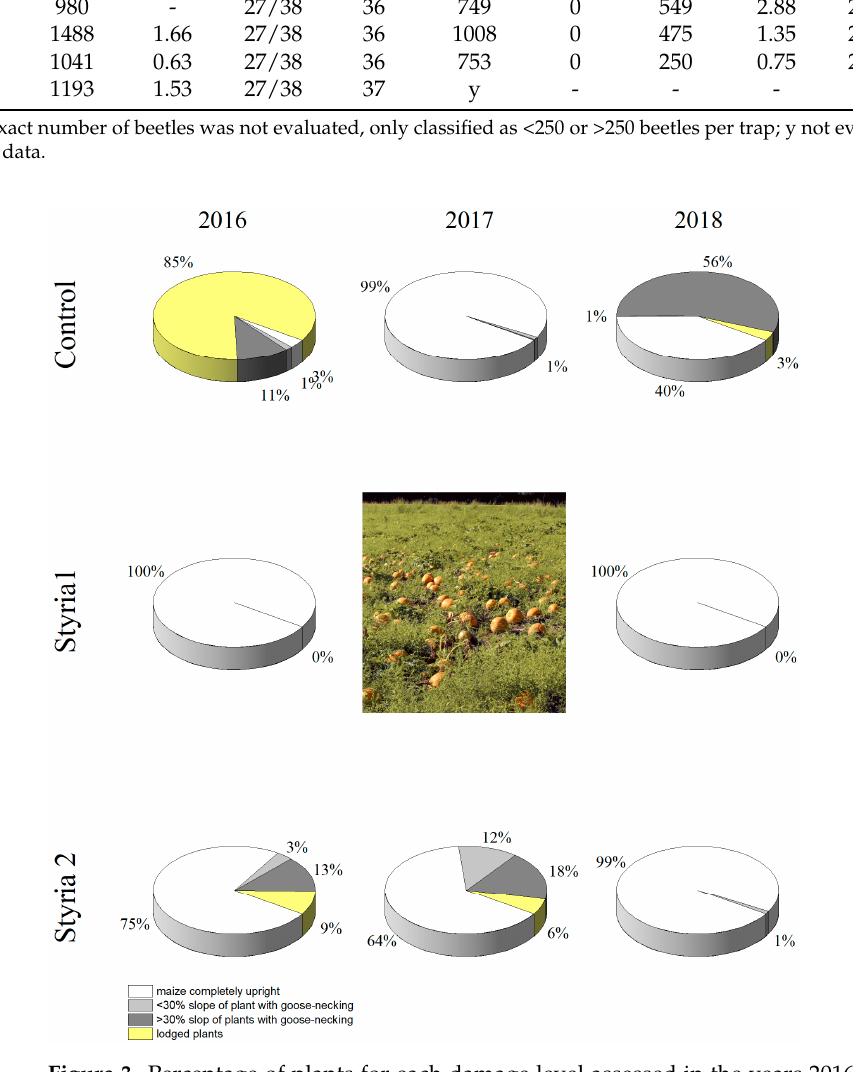
Figure 3. Percentage of plants for each damage level assessed in the years 2016 to 2018 in Styria. Healthy plants are indicated as upright, completely fallen plants as lodging. The damage for Styria 1 in 2017 could not be surveyed due to the cultivation of pumpkin ( Cucurbita pepo L. var. styriaca ) as part of the crop rotation.